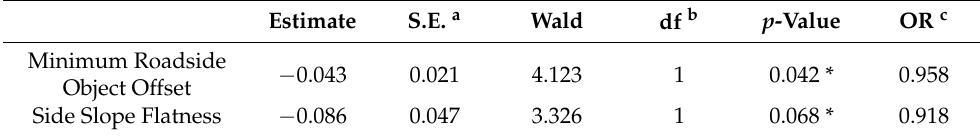
Table 3. Final Regression